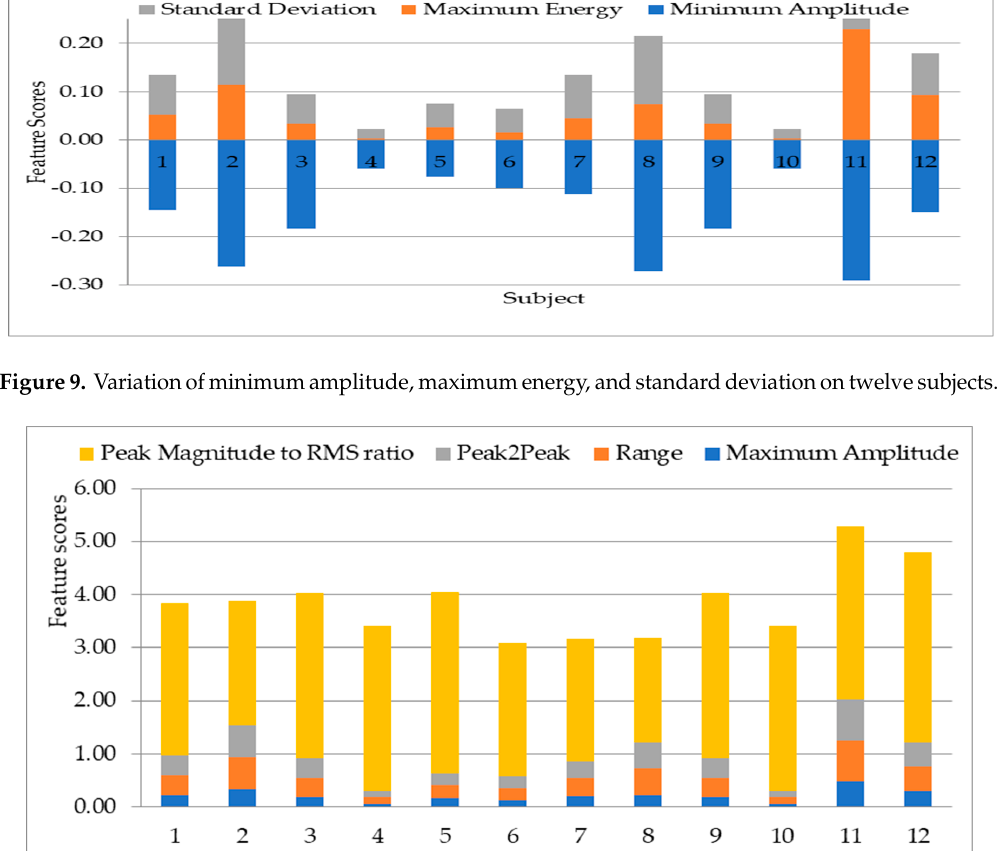
Figure 11. Showing variation of mid frequency, root mean square and average frequency on twelve subjects. From the 13 statistical features, 12 statistical features of the mean, mean of energy, variance, minimum amplitude, maximum energy, standard deviation, maximum amplitude, range, peak2peak, peak magnitude to RMS ratio, mid frequency and root mean square were chosen. The 12 selected features are applied for the experiment using 30 subjects’ data. The features will be extracted from each of the decomposed signal of detail (D1–D3) and approximation (A1–A3) of the different biorthogonal wavelet family. 4.2. Result on Experiment 2: Classification Sub-Band Features To extract features from the signal, fifteen different wavelets from biorthogonal wavelet family are used to decompose the signal into three sub-bands. To evaluate the performance of the three sub- bands of approximation coefficient and detail coefficient, the ten features selected are applied to three sub-bands of approximation of coefficient and detail coefficient from the data of 30 subjects. The use of 3 sub-band (decomposition level) is because of the bioelectrical signal frequency of the heart rate variability. This is necessary because it should correlate with the frequencies necessary for